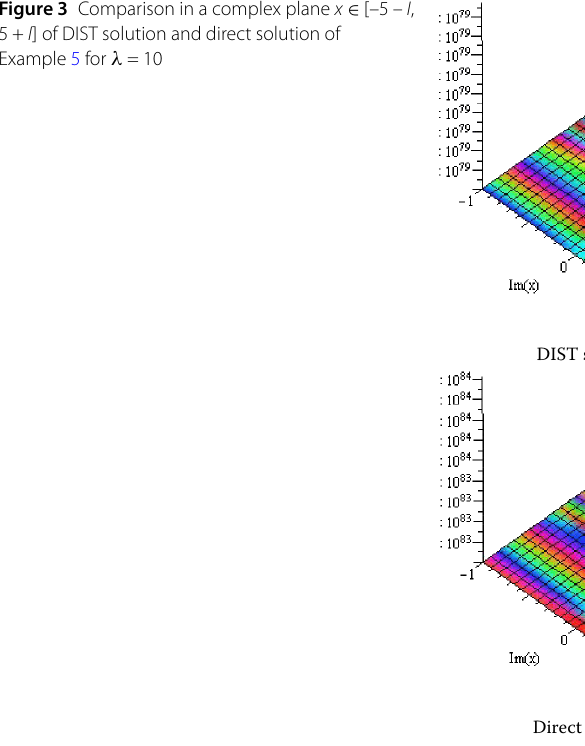
Figure 3 Comparison in a complex plane x ∈ [–5 – I , 5 + I ] of DIST solution and direct solution of Example 5 for λ =